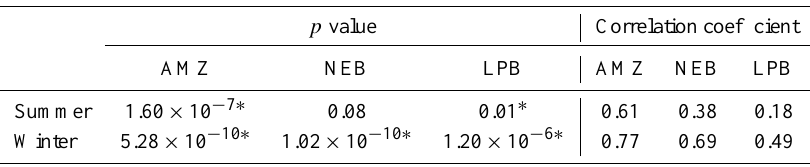
Table 3. p value and Pearson’s correlation coefficient at the level of significance of 5% between the ANNs and observed data from the CRU in all regions under study.